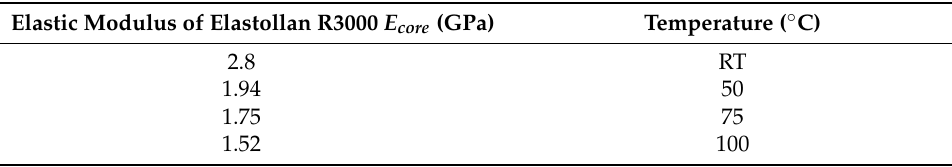
Table 3. Modules of elasticity of Elastollan-R3000 at different temperatures [29].